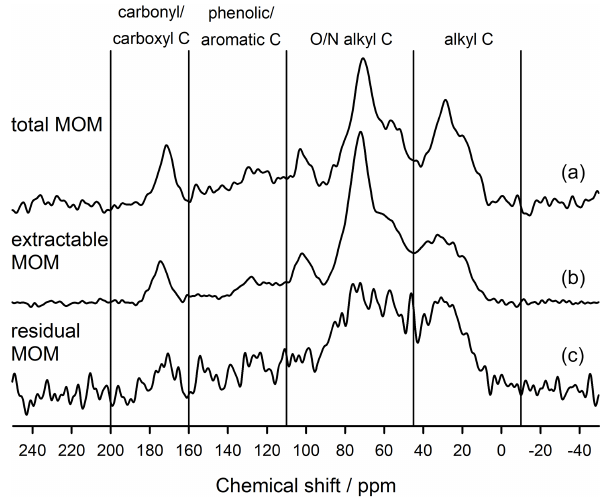
Figure 7. CPMAS- 13 C-NMR spectra of OM from the 0–5cm layer of the Hainich site (Cambisol, beech). (a) Total mineral- associated OM (MOM); (b) MOM fraction extracted into NaF– NaOH; (c) residual OM after extraction of MOM into